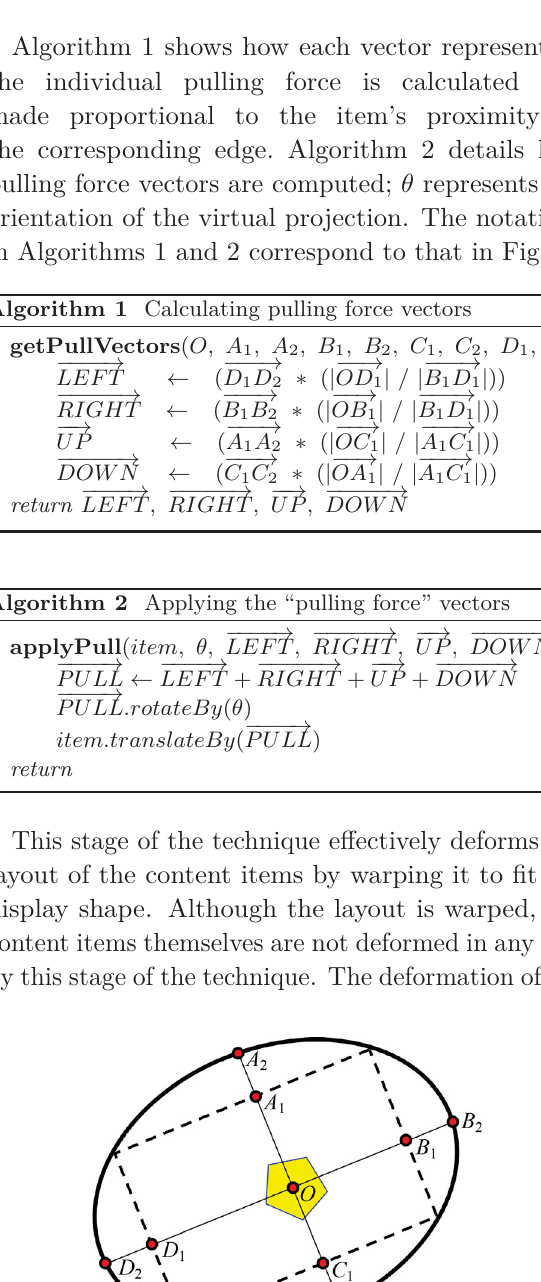
Fig. 3 An example of the position pulling